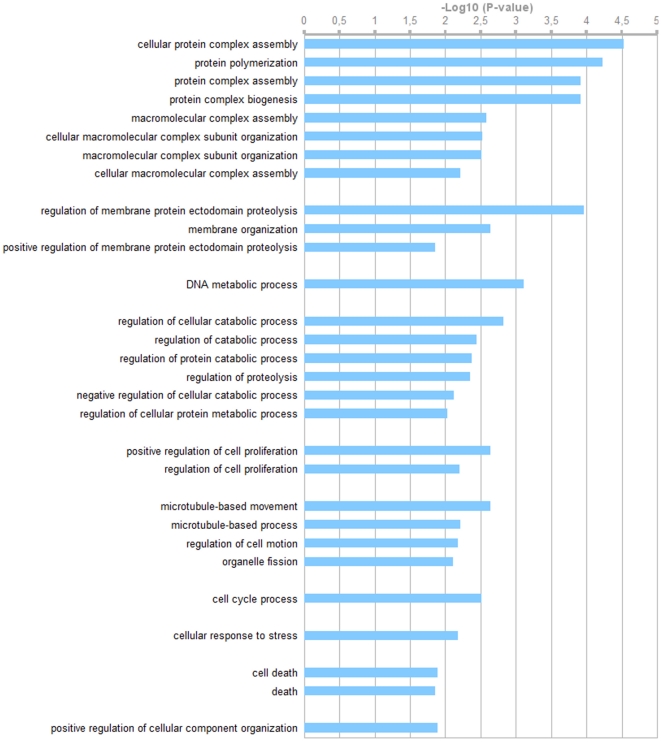
Gene enrichment analysis of the 300 genes of the infection signature.Discriminatory genes were analyzed by DAVID for associations with particular Gene Ontology terms. The negative Log10(P-values) of enriched terms (plotted in bar) refer to how significant an association a particular ontology term has with the gene list. The 30 most significant biological process are grouped according to their biological meaning.